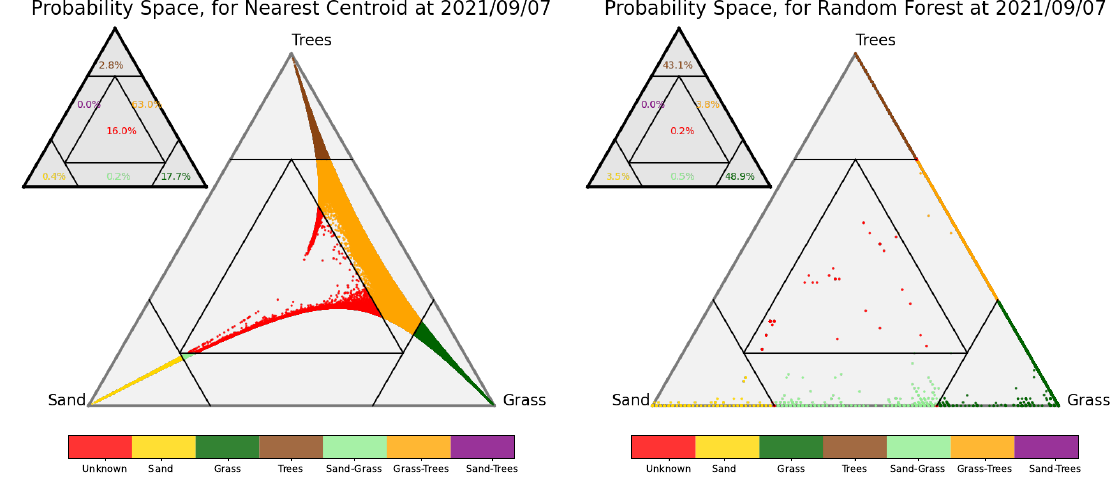
Figure 8. Scatter plot of pixel probabilities as output by the Nearest Centroid method, left, and the Random Forest method, right. In both cases, the percentage of pixels for each of the seven sub-polygons is given in the small triangles at the top left of each scatter